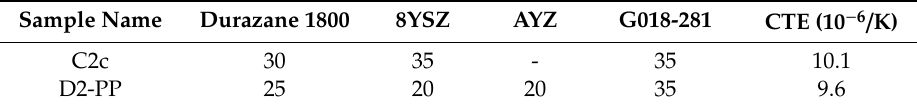
Table 3. Compositions of the composite top coats after pyrolysis (vol.